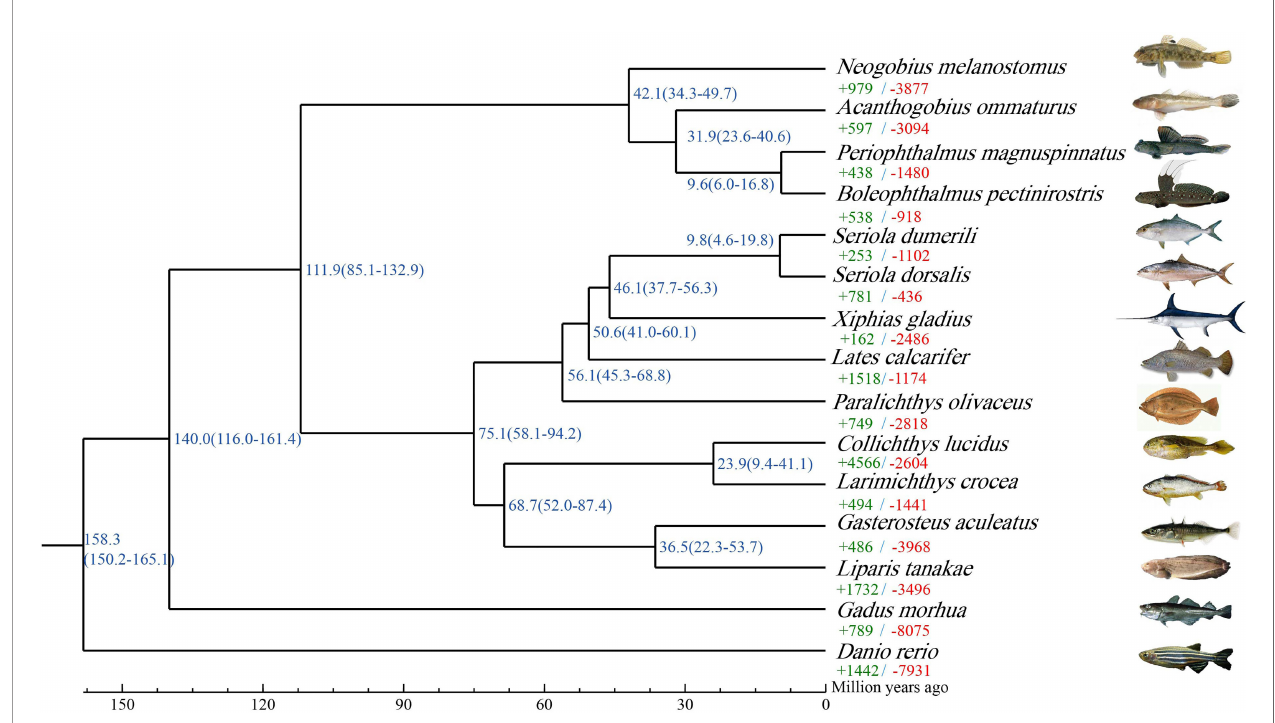
FIGURE 2 | Phylogenetic analysis and divergence time tree of A. ommaturus with 14 other fi sh species. Each branch site shows the estimated species divergence time (million years ago). Each branch shows the number of expanded (+, green) and contracted ( − , red) gene families. The source of species images were shown in Supplementary Table 2